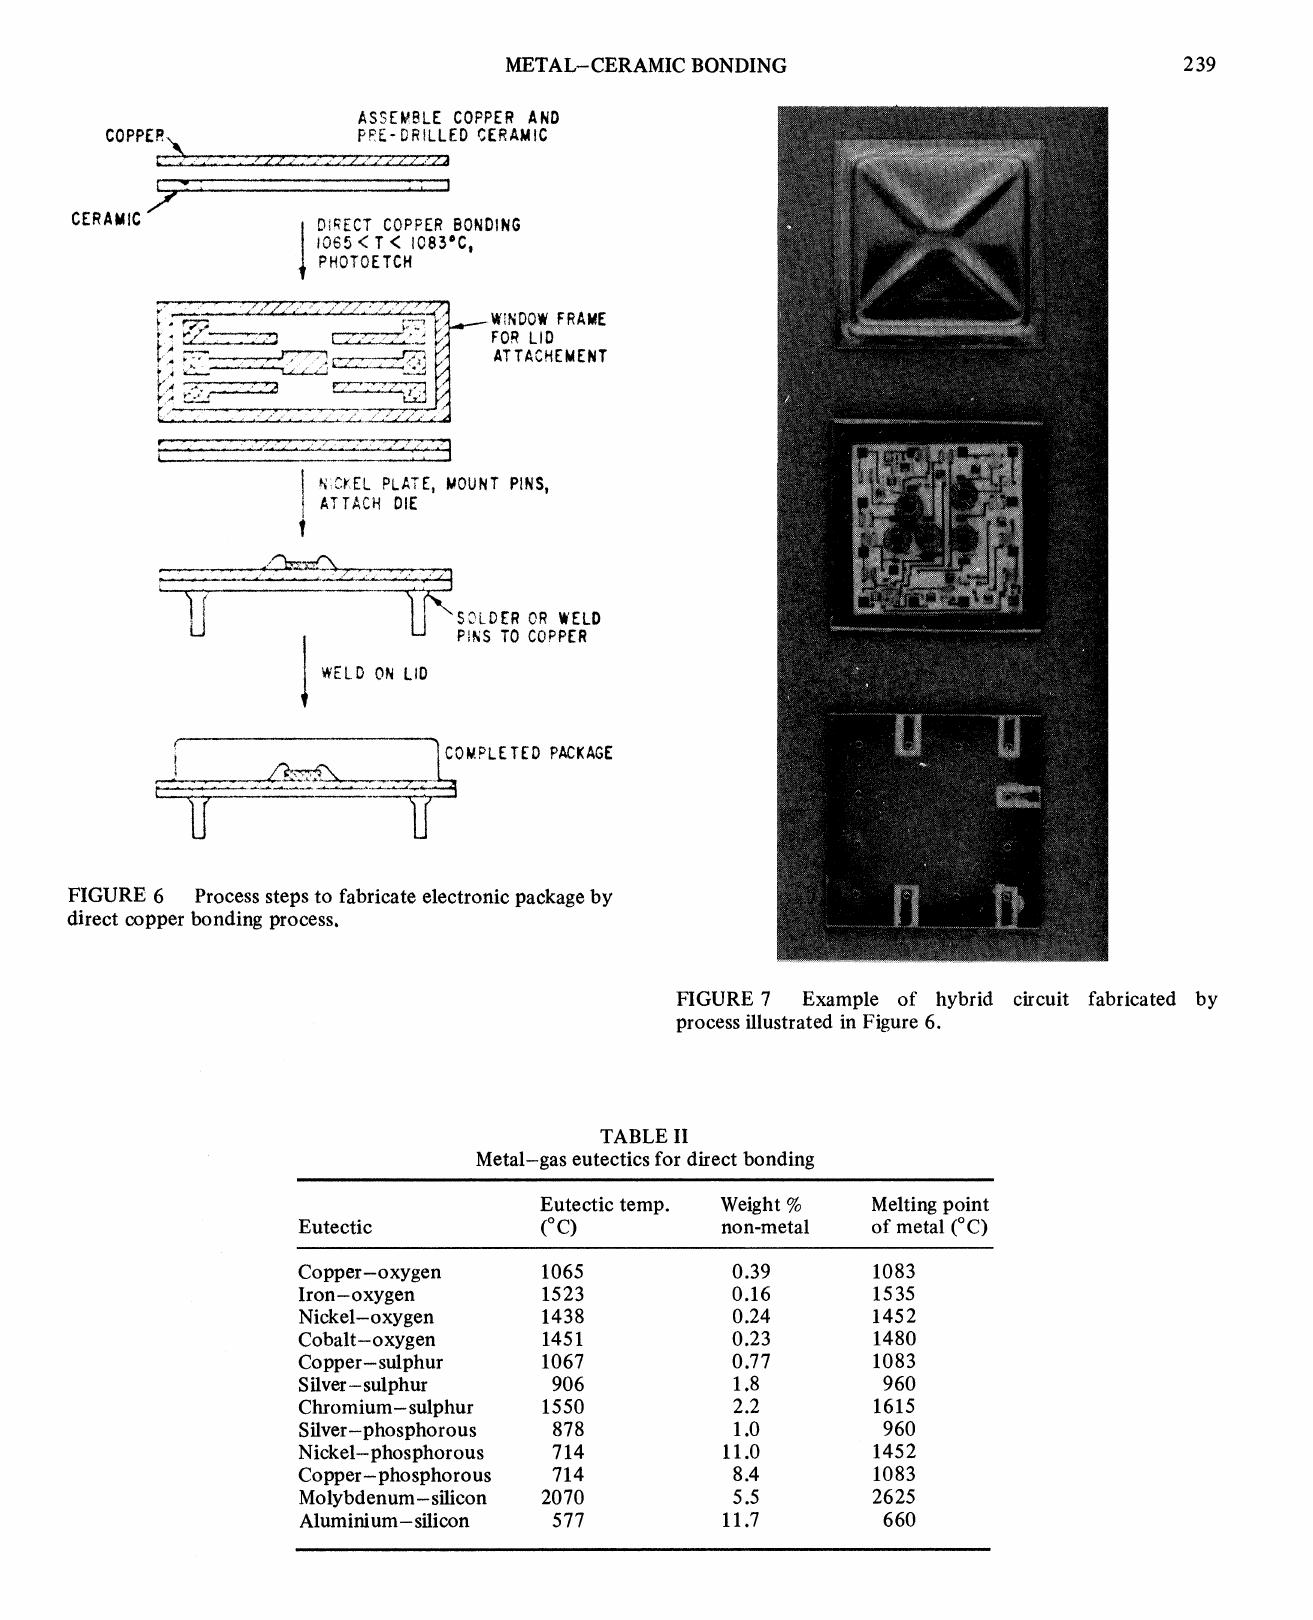
TABLE II Metal-gas eutectics for direct